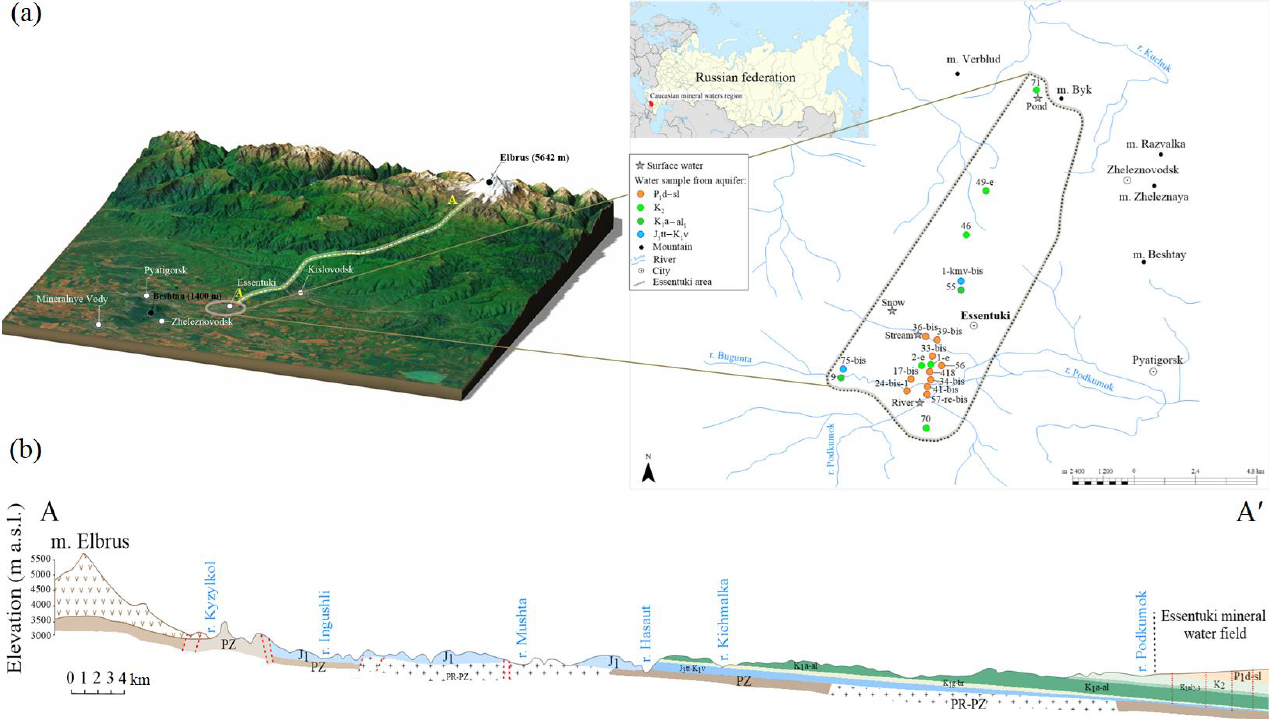
Figure 1. Study area: ( a ) sampling points; ( b ) geological cross-section of A-A ’ in the